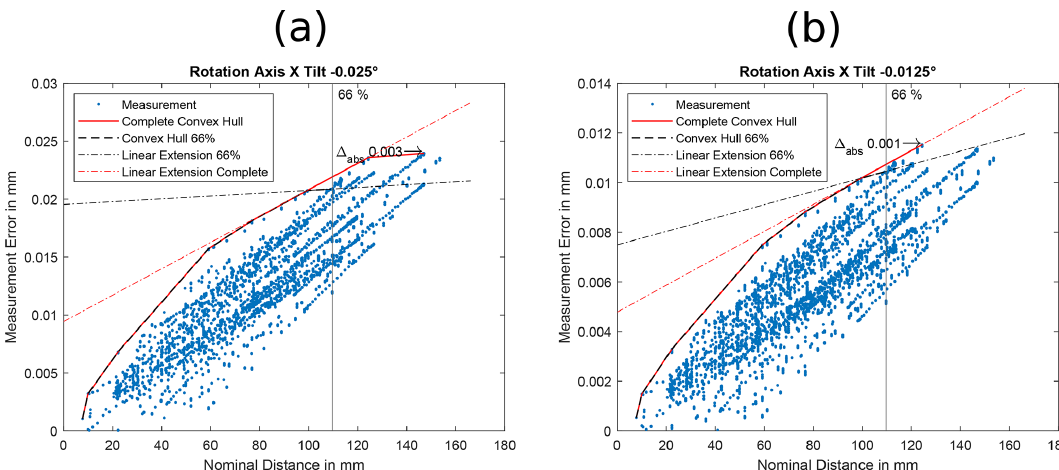
Figure 10. Convex hull analysis of non-linearity for the rotation axis tilt around the x axis (axis perpendicular to beam and rotation axis; see Fig. 2) by − 0 . 0125 and − 0 . 025 ◦ . The plots show the data points, both convex hulls (using points until 66% and using all points) as well as derived MPE specifications. The (cid:49) abs marks the data point with the largest distance to the 66% MPE specification. The simulations are part of simulation set I. We are convinced that a human would visually not specify such a low slope for the below 66% MPE specification as the automated algorithm used in this study. In this sense, the criterion employed here is, as discussed in the text, a worst-case criterion. We would expect most MPEs specified based on this picture to follow the general linear trend of the data